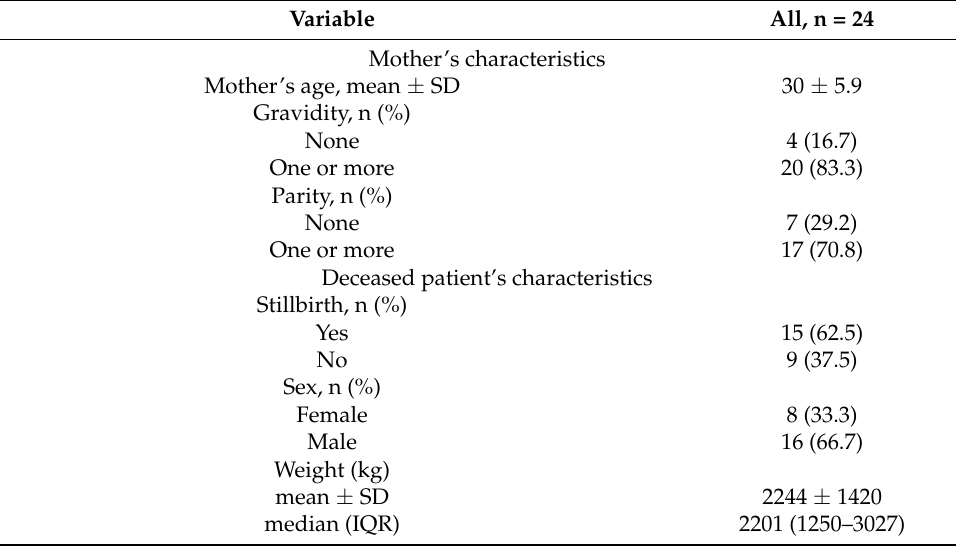
Table 1. Baseline characteristics of the study deceased